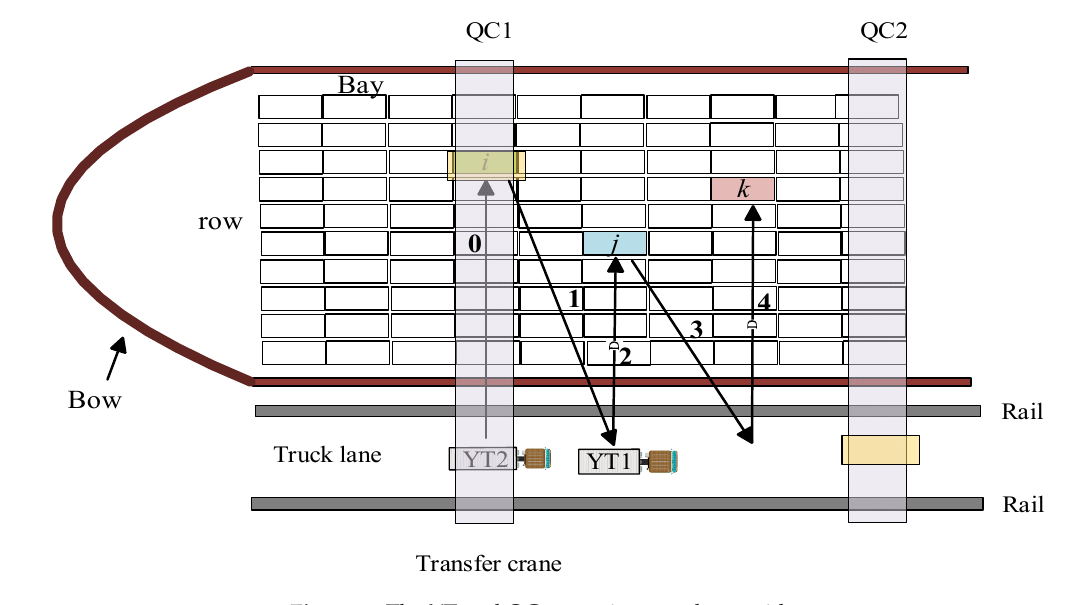
Figure 5. The YT and QC operations on the seaside.